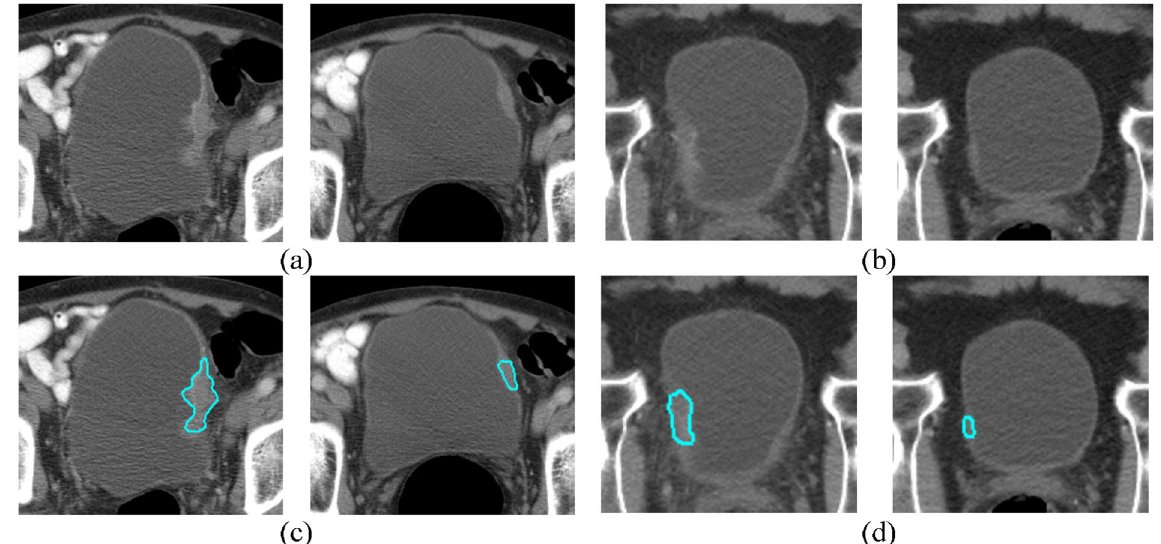
Figure 1. Bladder lesion segmentations. Two segmented bladder cancers are illustrated. The lesions in the pre- and post-treatment scan pairs shown in ( a , b ) are segmented using AI-CALS, as shown in ( c , d ), respectively. The pre-treatment scan is on the left and the post-treatment scan is located on the right of each pair.